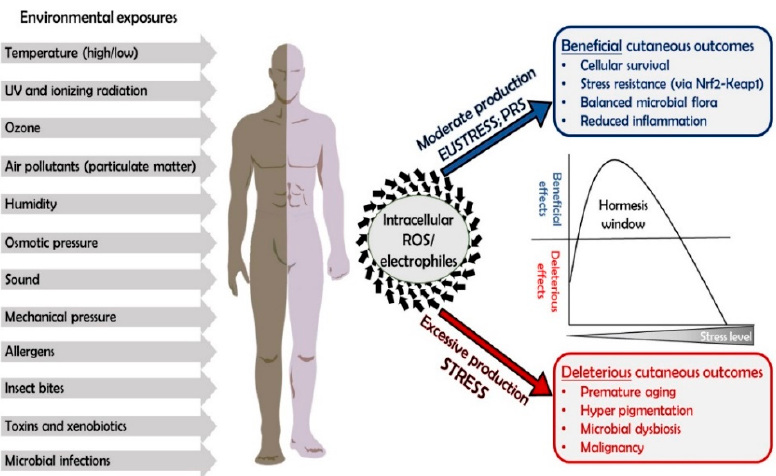
Figure 1. Stress exposure is translated to “oxidative stress” (OS) . Many exposures of the skin to the elements (either physical, chemical or biologic) ultimately leads to the augmentation of reactive oxygen species (ROS) intracellular concentrations. This may have either deleterious or positive outcomes for the skin, depending on the duration and location of the exposure and on the downstream cellular response (i.e., ROS induction levels). This phenomenon sustains the principal of